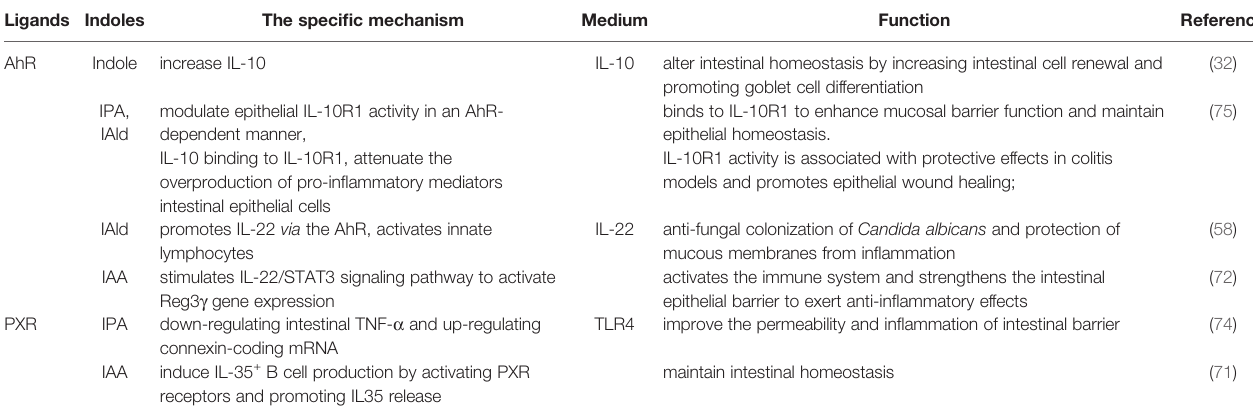
TABLE 2 | The mechanism of indoles regulating intestinal action through AhR. Ligands Indoles